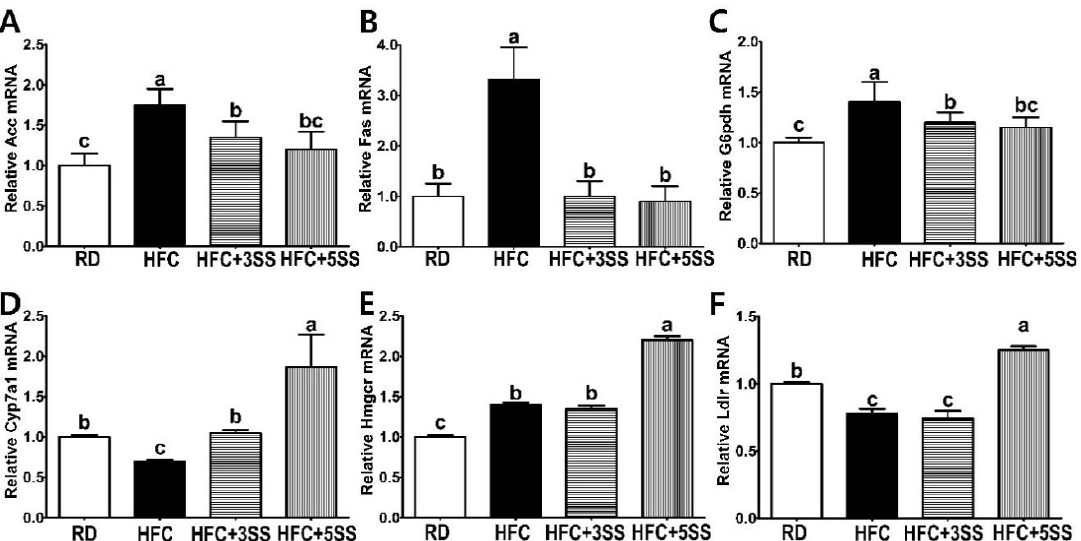
Figure 9. Effect of S. sieboldii Miq. root powder (SS) on hepatic mRNA expression. Experimental rats were fed a regular diet (RD) or a high-fat and high-cholesterol (HFC) diet with or without Stachys sieboldii Miq. root powder (SS; 3 or 5%) supplementation for 6 weeks. Hepatic ( A ) acetyl-CoA carboxylase (ACC), ( B ) fatty acid synthase (FAS), ( C ) Glucose-6-phosphate dehydrogenase (G6pdh), ( D ) cholesterol 7 alpha-hydroxylase (Cyp7a1), ( E ) 3-hydroxy-3-methyl-glutaryl-coenzyme A reductase (Hmgcr) and (F) low-density lipoprotein (LDL) receptor (Ldlr) mRNA expression. RD, regular diet; HFC, high-fat and high-cholesterol diet; HFC + 3SS, High-fat and high-cholesterol diet + 3% of Stachys sieboldii Miq. root powder; HFC + 5SS, high-fat and high-cholesterol diet + 5% of Stachys sieboldii Miq. root powder. Values are means ± standard deviation, n = 8. Data were analyzed using one-way ANOVA followed by Tukey’s post hoc test. Means labeled without a common letter differ significantly, p < 0.05.